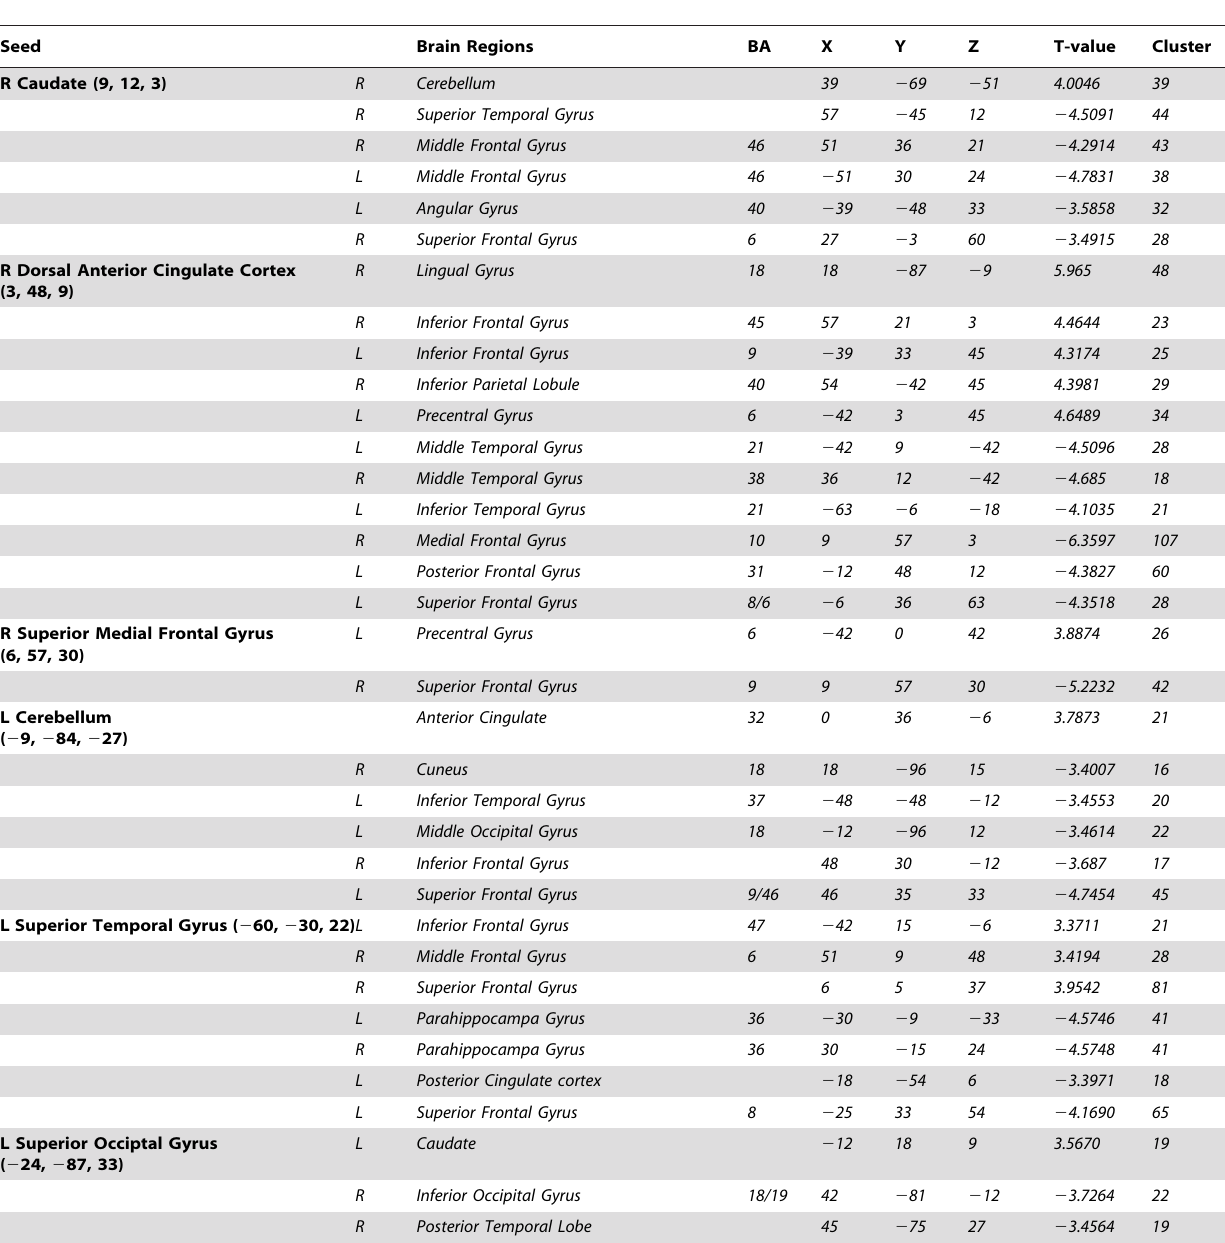
Table 2. Differences in the functional connectivity of the regions with altered ALFF value between HD and NC (p , 0.01, AlphaSim corrected, T . 2.7633 or ,2 2.7633, cluster .